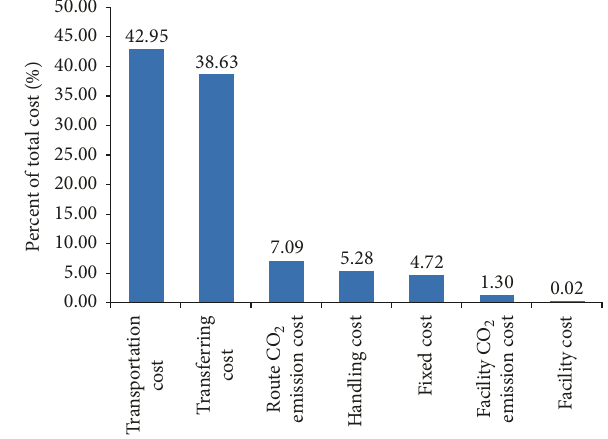
Figure 8: Total cost ratios in different parts of the supply